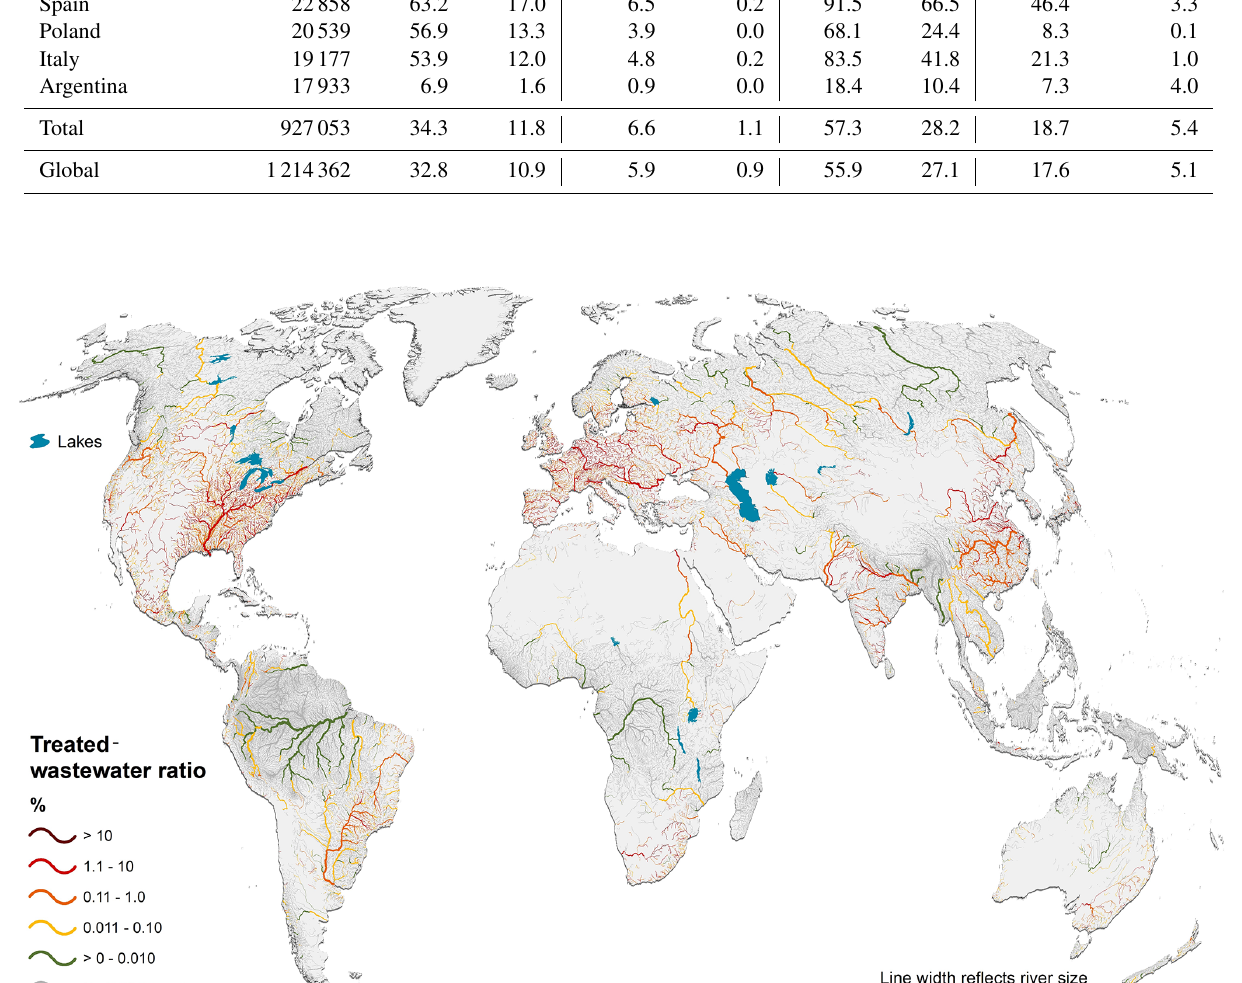
Earth Syst. Sci. Data, 14, 559–577,